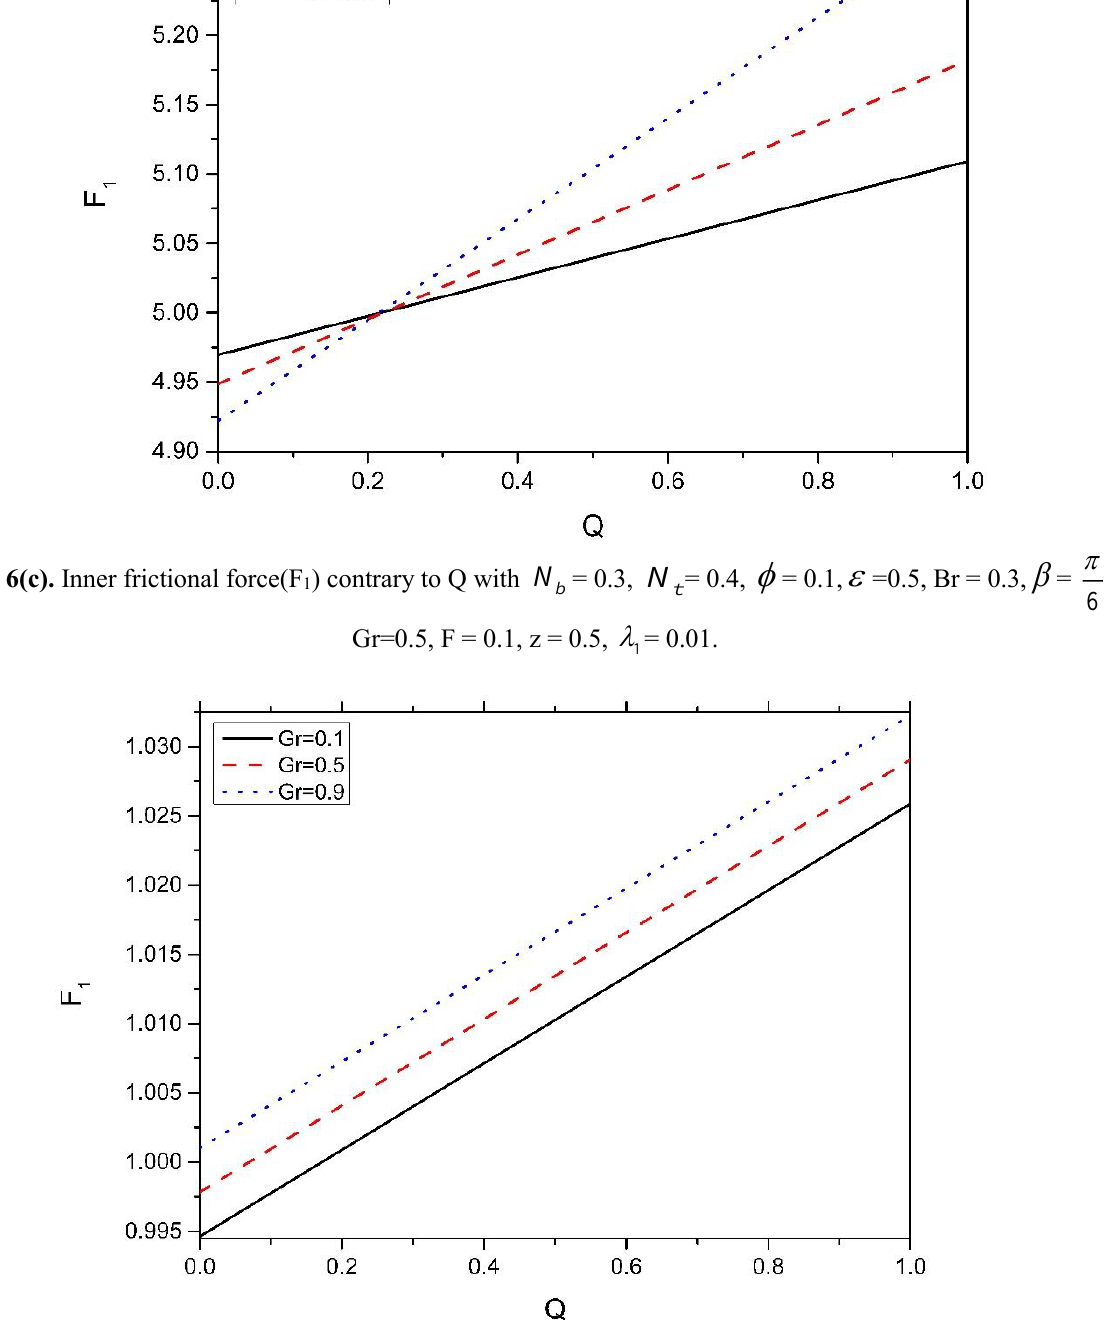
N = 0.3, N = 0.4,  =0.5,  = 0.01, Br = 0.3, b t  = 1